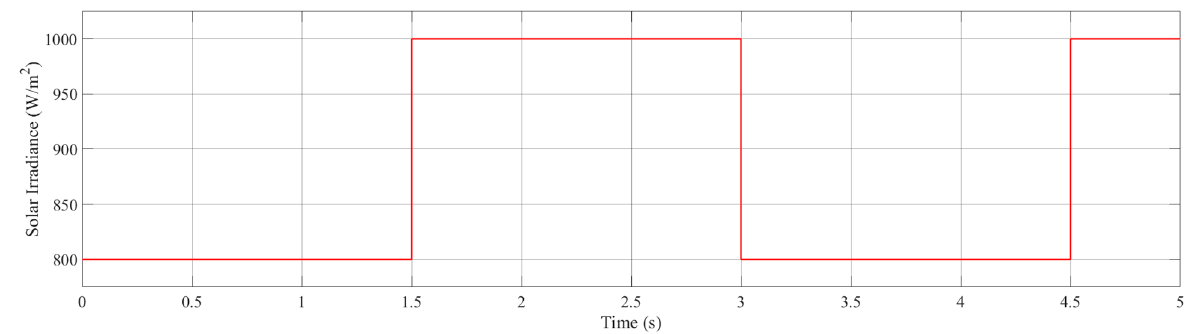
Figure 17. Solar Irradiation variations.